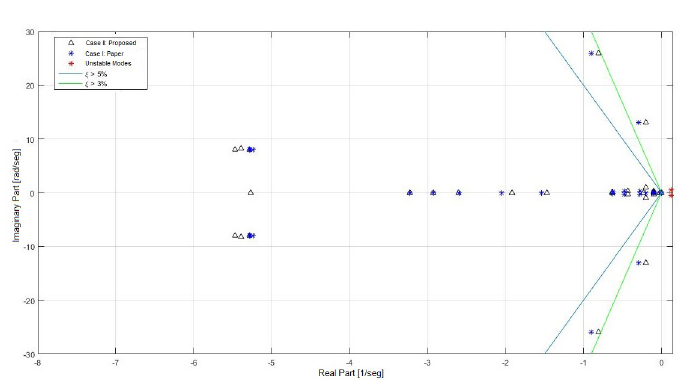
Figure 15. Eigenvalues in heavy load operation condition.